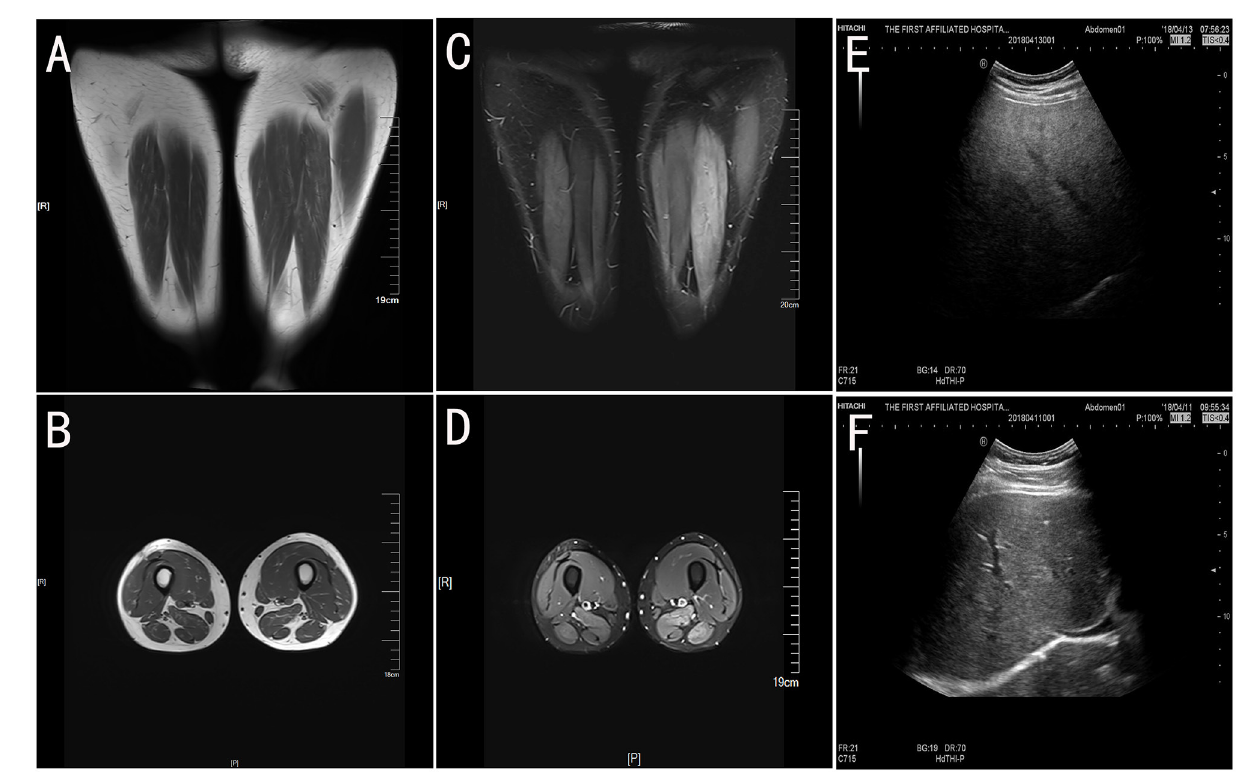
FIGURE1 The muscle MRI of lower limbs and abdomen ultrasound. The T1-weight images (A, B) showed slightly atrophy of bilateral lower limbs. Fat suppression (T2-weighted short tau inversion recovery, T2-STIR) images (C, D) have high signal intensity in the bilateral limb muscles, which indicates muscle injury. The abdomen ultrasound (E) showed obvious signs of a fatty liver compared with the health control (F) .